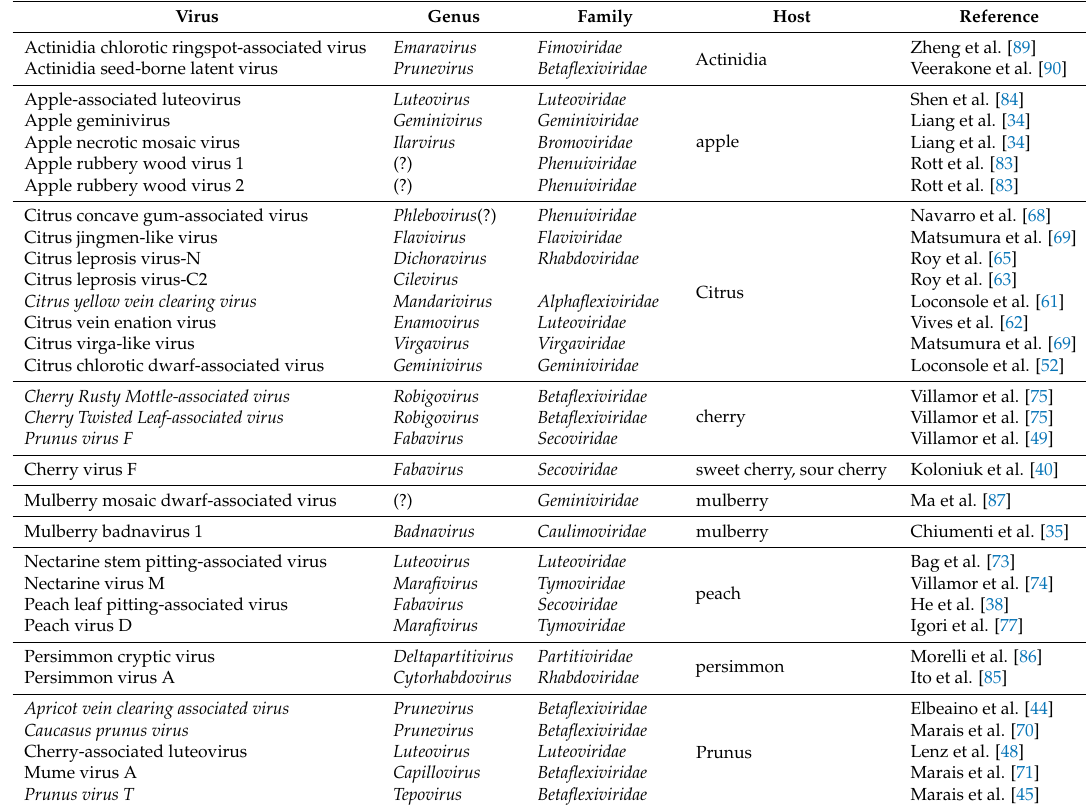
Table 2. De novo